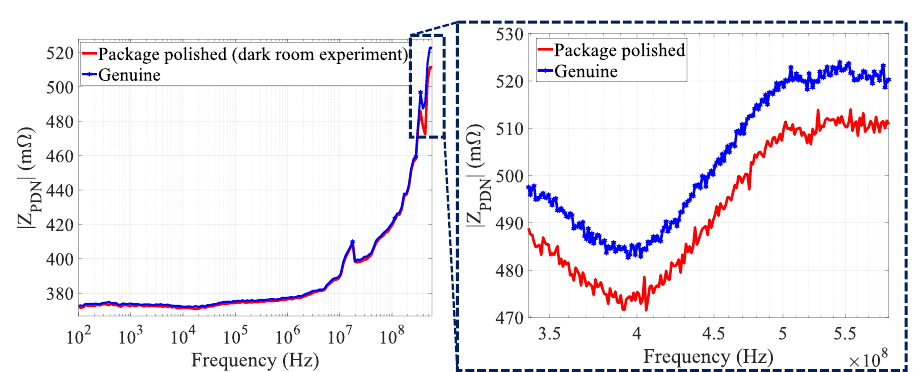
Figure 10: The mean of 105 impedance profile signatures when the surface of the FPGA package is